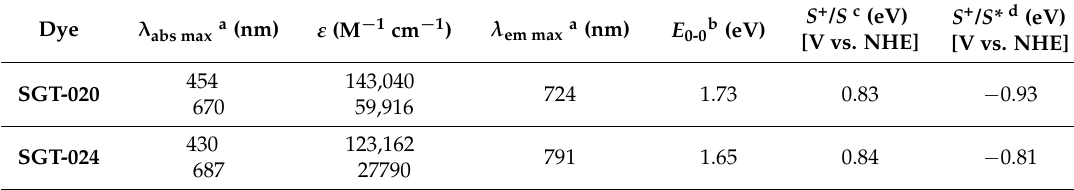
Figure 2. Energy-level diagram of SGT-020 and SGT-024 . Table 1. Photophysical and electrochemical data for SGT-020 and SGT-024 .